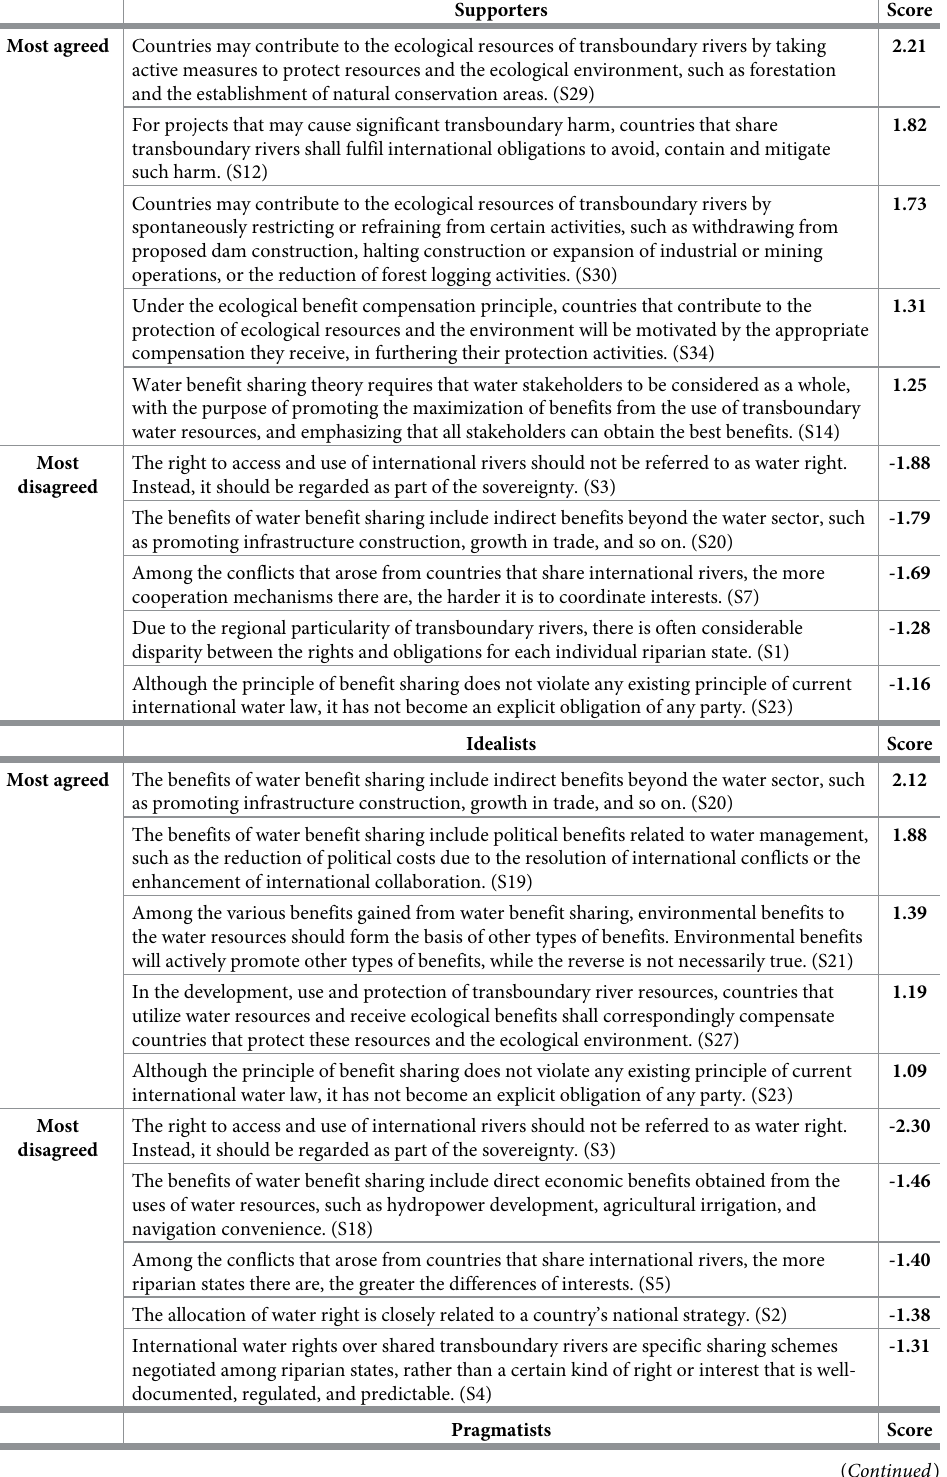
Table 4. Notable views on Q statements by groups.